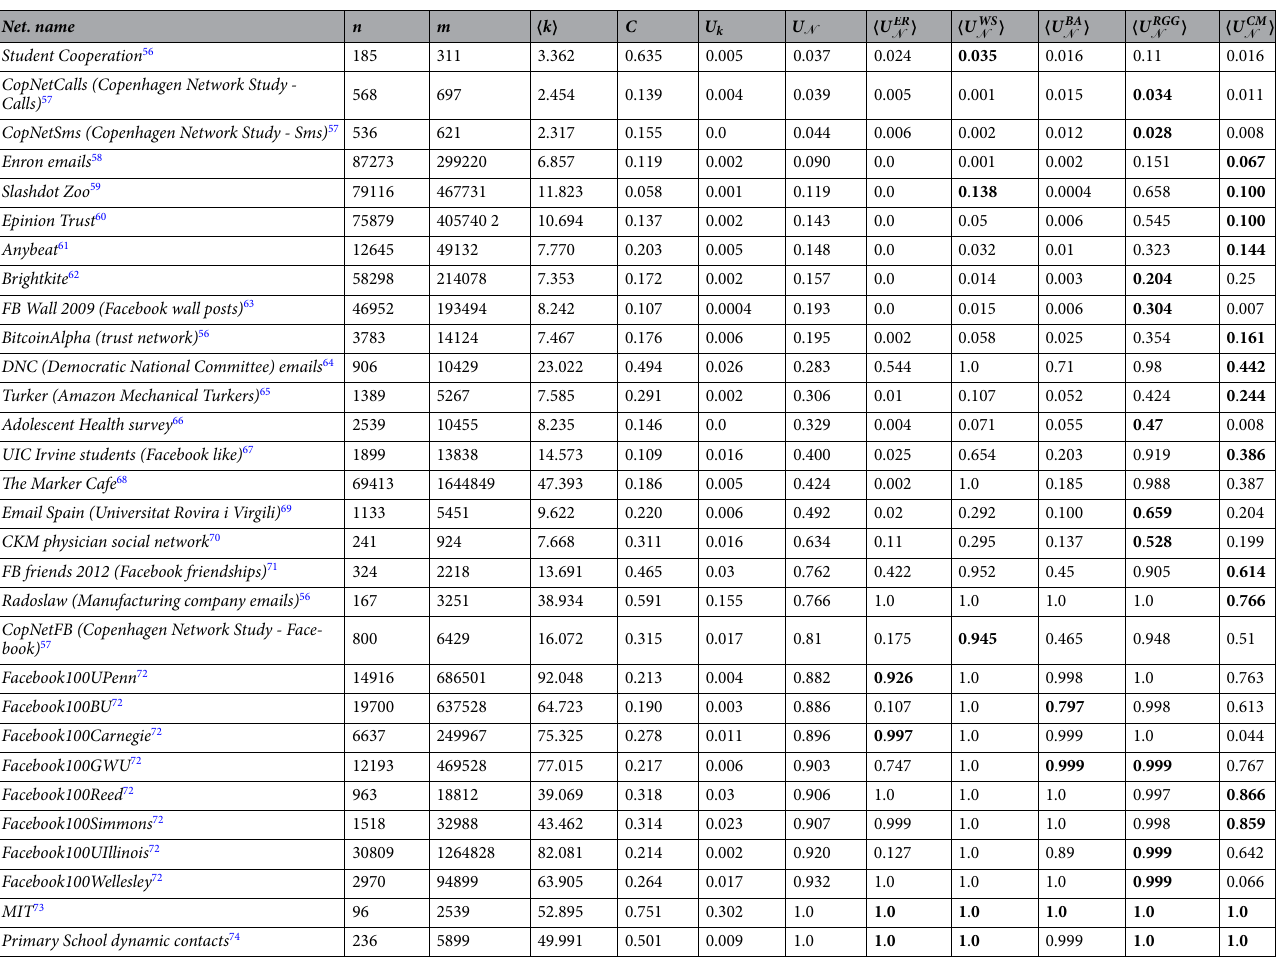
Table 1. 30 real-world network datasets’ basic measures (number of nodes n , number of edges m , average degree (cid:31) k (cid:30) , average local clustering coefficient C ), degree uniqueness U k , uniqueness of neighborhoods U N , and expected U N values for the corresponding ER, WS, BA, RGG, and CM models (with the same number of nodes and average degree), computed as a mean of 10 realizations. The table is sorted by increasing value of U N . The models’ expected U N values that are closer to each real network are highlighted in bold (if two models produced the same value, they are both